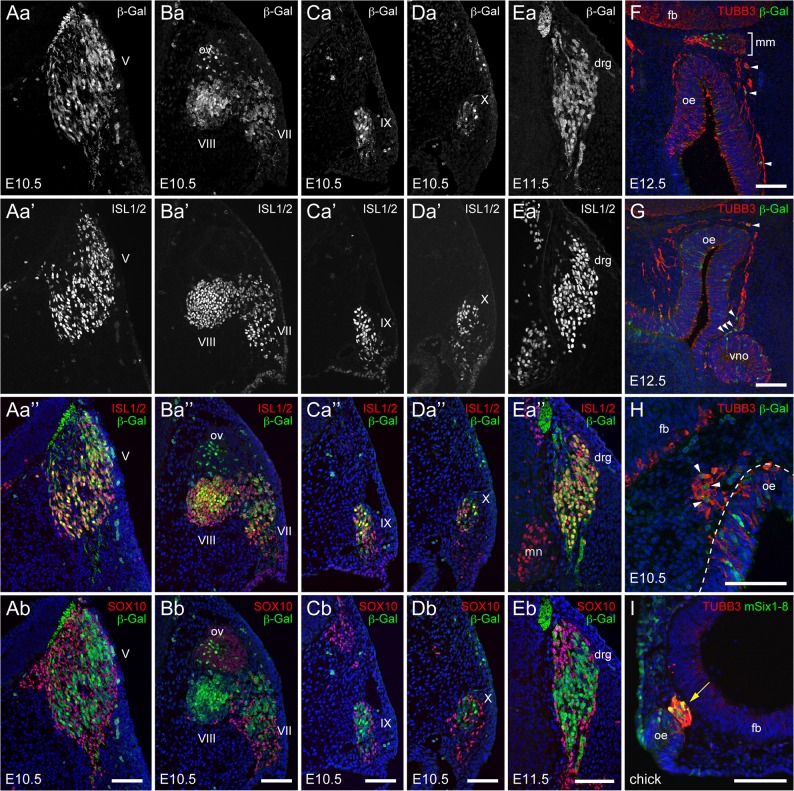
mSix1-8-NLSCre induces sensory neuron-specific recombination in mouse embryos.(A-I) Immunofluorescence analysis of Cre-mediated recombination in mSix1-8-NLSCre/R26R-LacZ double transgenic embryos. Distribution of ß-Gal was examined at E10.5 (A-D, H), E11.5 (E) and E12.5 (F, G). At E10.5, ß-Gal (Aa) co-localized with a neuron marker ISL1/2 (Aa') in the trigeminal ganglion (yellow signals in Aa''), geniculate-vestibuloacoustic ganglion complex (Ba, Ba', Ba''), petrosal ganglion (Ca, Ca', Ca'') and nodose ganglion (Da, Da', Da'') in transverse sections through the cervical area. In contrast, the same sections stained for a glial marker SOX10 showed no overlap of ß-Gal (green)-positive cells with SOX10 (red)-positive cells in all cranial sensory ganglia (Ab, Bb, Cb, Db). At E11.5, ß-Gal (Ea) also co-localized with ISL1/2 (Ea') in the DRG (yellow signals in Ea'') in a transverse section through the trunk region but not with SOX10 on the same section (Eb). In the frontal sections through the OE at E12.5 (F, G), ß-Gal (green)-positive cells were detected not only in the OE (F, G) but also in the vomeronasal organ (G) and in the surrounding mesenchyme along the TUBB3 (red)-positive axons of the olfactory and vomeronasal sensory neurons (white arrowheads). Many ß-Gal-positive cells were also found in the "migratory mass (white square bracket)" comprising placode-derived migratory cells and axons of olfactory sensory neurons located ventral to the forebrain (F). (H) At E10.5, ß-Gal (green)-positive cells were found in the OE (demarcated by white dotted line) and in an aggregate of TUBB3-positive cells (white arrowheads) located next to the OE. (I) Immunofluorescence analysis of Six1-8 enhancer activity in chick. Frontal section through the olfactory pit of a representative chick embryo at 48 h.p.e. EGFP (green) derived from pT2A-BB-mSix1-8-EGFP was detected in the OE and in an aggregate of TUBB3 (red)-positive cells (yellow arrow) located subjacent to the OE, a likely avian homolog of the rodent migratory mass. DAPI was used for nuclear staining (blue, Aa'', Ab, Ba'', Bb, Ca'', Cb, Da'', Db, Ea'', Eb, F-I). In all panels, dorsal is to the top and midline is to the left (A-E, H) or right (F, G, P). drg: dorsal root ganglia, fb: forebrain, mm: migratory mass, oe: olfactory epithelium, ov: otic vesicle, vno: vomeronasal organ, V: trigeminal ganglia, VII: geniculate ganglia, VIII: vestibuloacoustic ganglion, IX: petrosal ganglion, X: nodose ganglion. Scale bars: 0.1 mm (A-I).